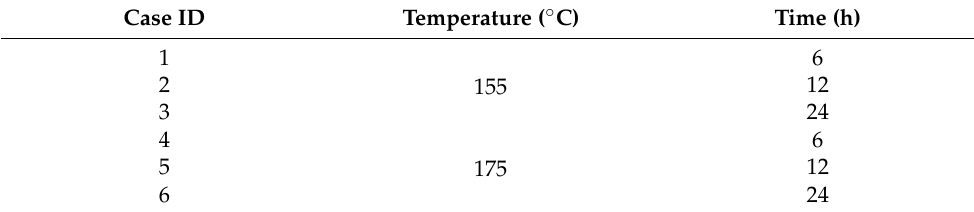
Figure 1. Specific dimensions of tensile test specimen (unit: mm). Table 1. Aging treatment